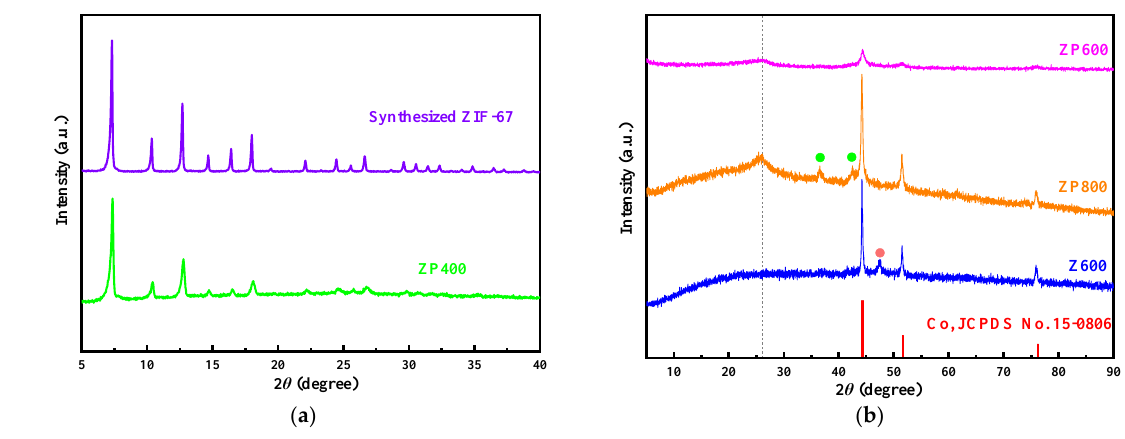
Figure 3. XRD patterns of ( a ) ZIF-67, ZP400, ( b ) ZP600, ZP800 and Z600. TEM and energy dispersive spectroscopy (EDS) were carried out to further charac- terize the internal structure and element distribution of ZP600. From the TEM images (Figure 4a) of ZP600, it can be seen that the cage-like PAN fiber structure spread uniformly all over the composite, which further indicated the effect of binding cobalt leaching. The element mapping results (Figure 4b – f) showed that C, N, O and Co were distributed uni- formly in ZP600, and the EDS result showed that the atomic ratio of C:N:O:Co in ZP600 was 88.37:3.40:2.90:5.34.